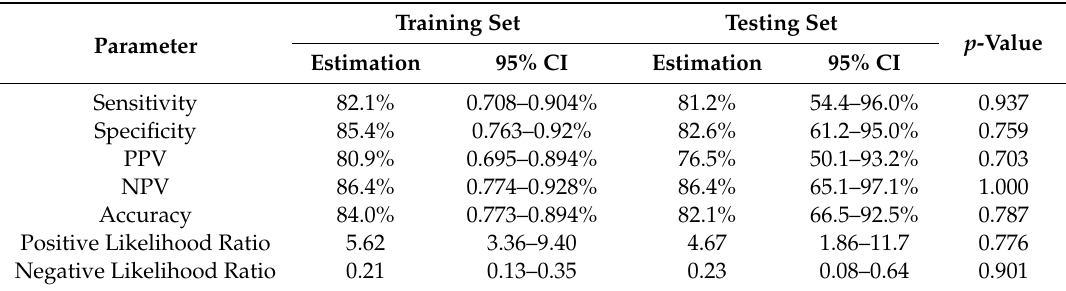
Figure 3. Receiver Operating Characteristic curves of the CADx model determined from the 10-fold cross-validation (CV) procedure during training (black line; AUC = 0.908) and testing (grey line; AUC = 0.913), with no significant difference ( p = 0.933). Table 3. Comparison of diagnostic accuracy measures of the CADx model performance during training and testing.